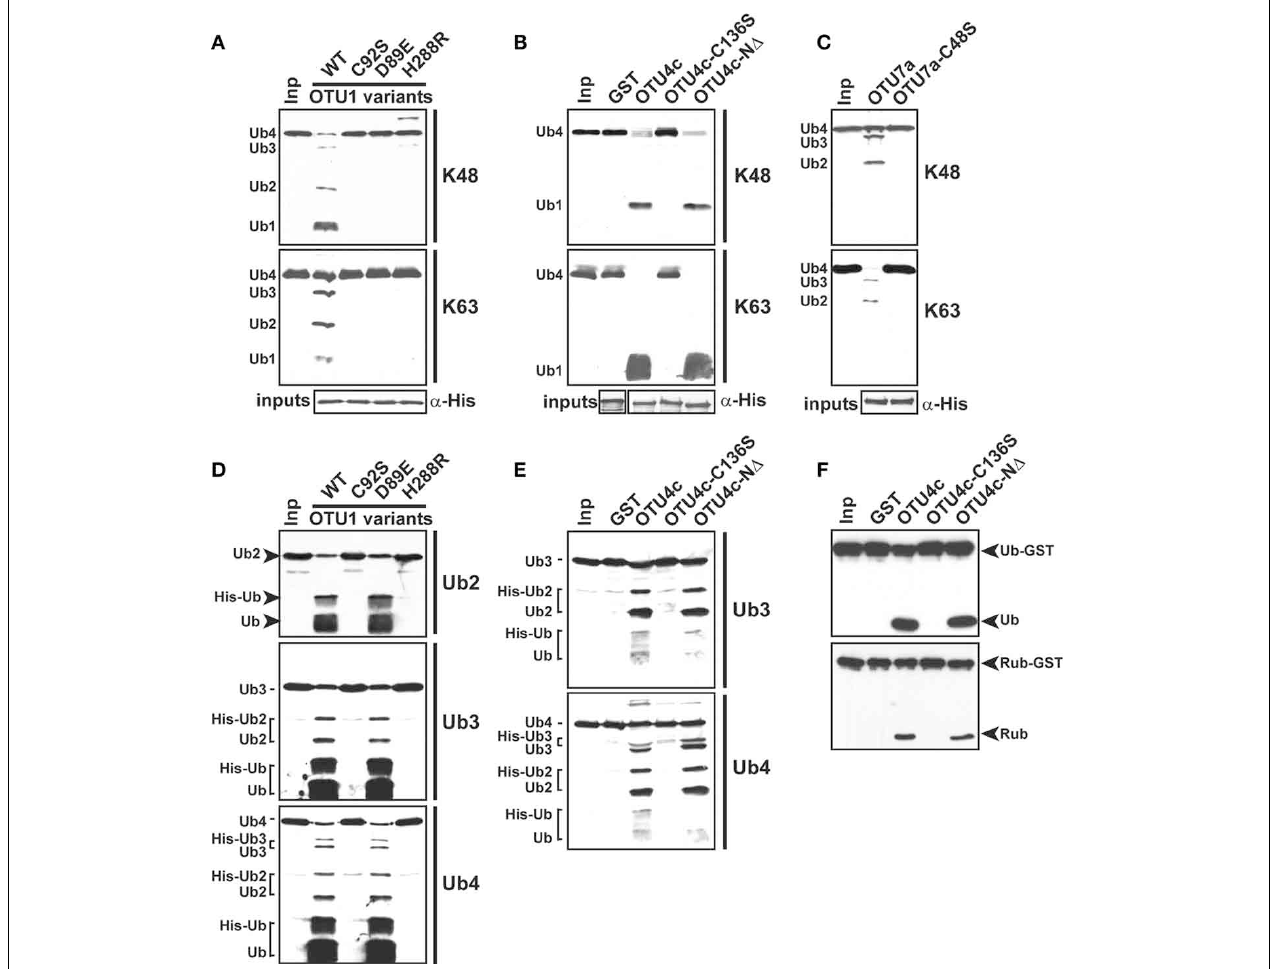
FIGURE 6 | The conserved catalytic triad is required for the deubiquitylation activities of A. thaliana OTU1, OTU4c, and OTU7a. (A)–(E) The catalytic roles of the conserved D89 in OTU1, the conserved catalytic triad in OTU1, OTU4c, and OTU7a, and the 43 N-terminal residues in OTU4c for cleavage of K48- and K63-linked UB tetramers (A)–(C) , peptide bond-linked linear UB dimers (Ub2), trimers (Ub3), and tetramers (Ub4) (D,E) , and peptide bond-linked UB- and RUB-GST fusions (F) were examined by comparing the cleavage activities of the site-specific or deletion mutants, which included the OTU1 variants C92S, D89E, and H288R; OTU4c-C136S;